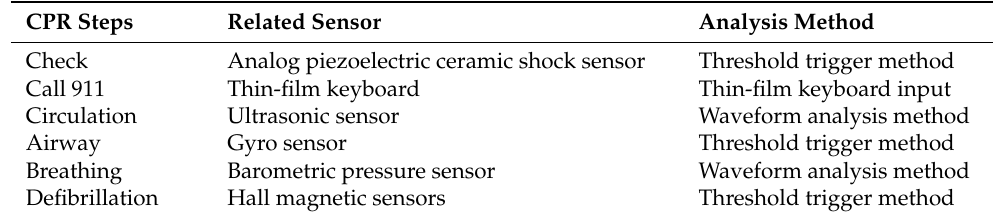
Table 6. The analysis method of the CPR